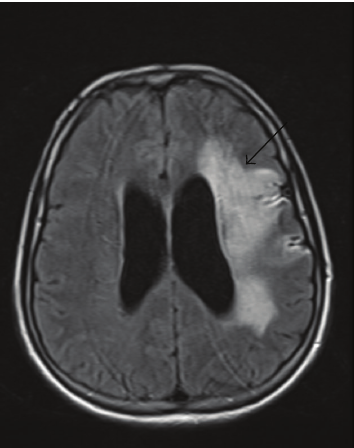
Figure 2: Occlusion from origin of left middle cerebral artery on MRI angiography.